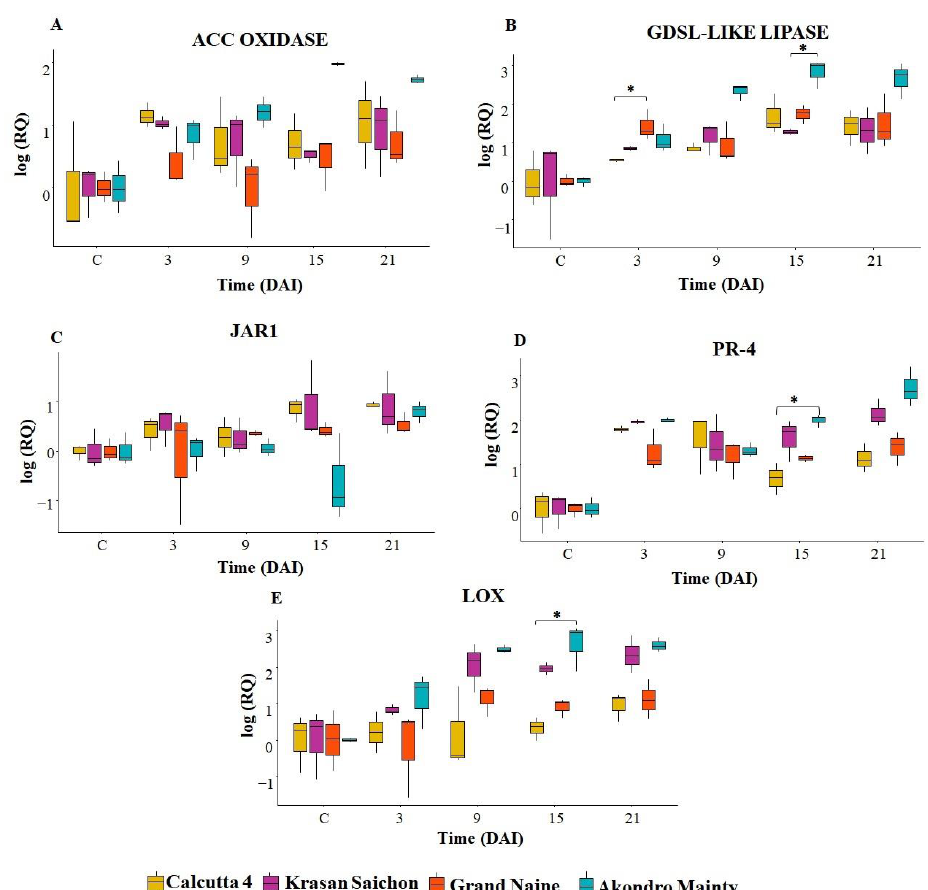
Figure 2. Box plots of the quantitative analysis of gene expression during the interaction of P. fijiensis and the banana cultivars Calcutta 4, Krasan Saichon, Grand Naine and Akondro Mainty. Relative expression levels (RT–qPCR) of the Acc oxidase ( A ), GDSL-like lipase ( B ), JAR1 (jasmonate resistant 1) ( C ), Pr-4 ( D ) and Lox lipoxygenase ( E ) genes. Quantifications were normalized using the reference gene 25S and tubulin. DAI: days after inoculation. Kruskal–Wallis with post hoc Dunn’s test was carried out to identify significant differences between the four cultivars within each time period * p < 0.05.